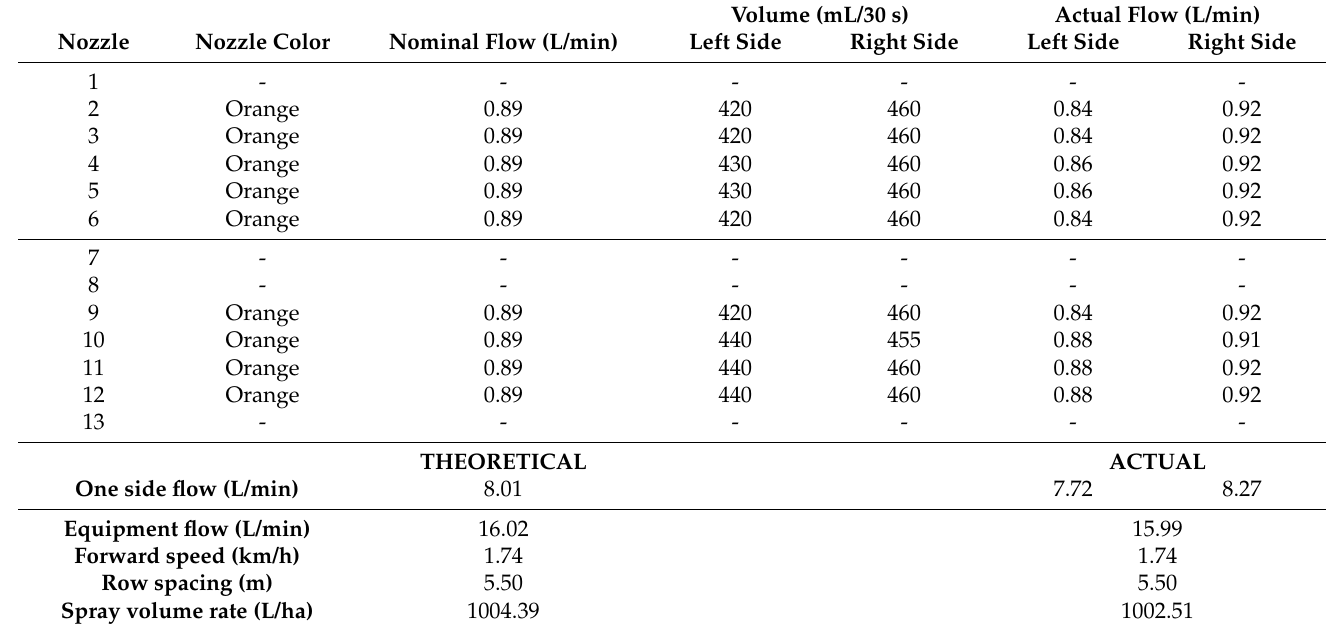
Table A13. Selection and calibration of nozzles for the C2 sprayer, with the following configuration: Adjusted to the vegetation/High & Low fan speed/Low spray volume rate/Drift-reducing nozzles (Coarse)/Pressure: 15 bar.